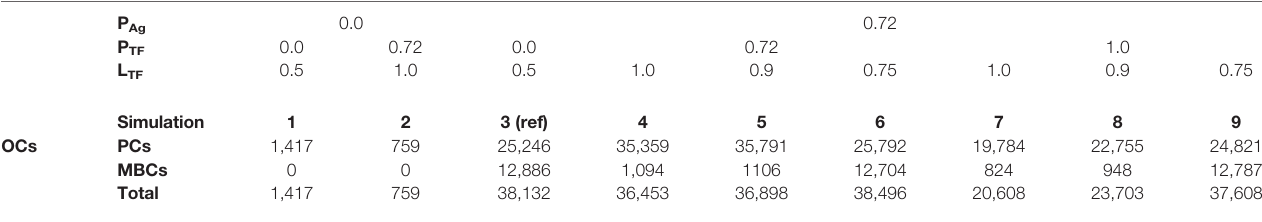
TABLE 4 | Number of OCs at day 21 originating from the fi rst set of simulations ( Table 2 ). P